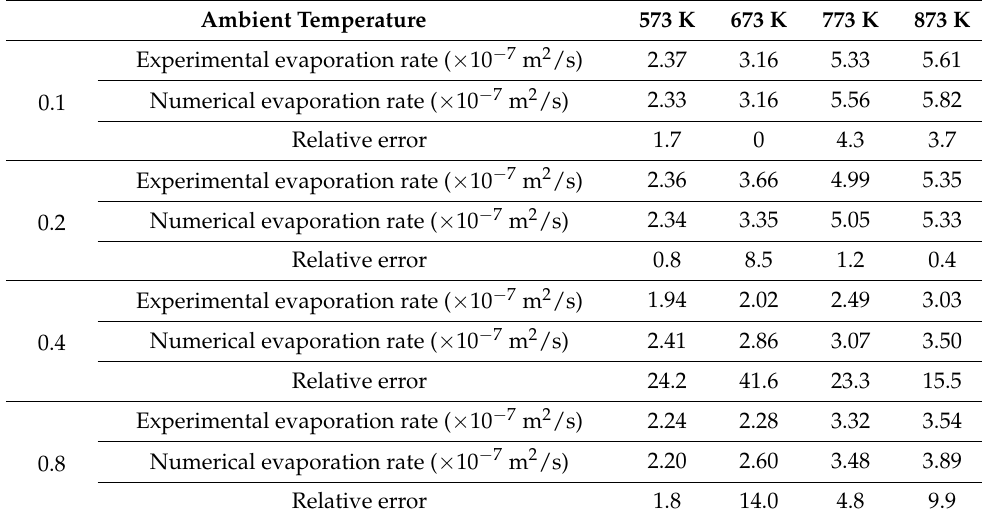
Table 3. Experimental and numerical simulation results of different mass fractions of ethanol-n- decane droplet evaporation in different gas temperatures.